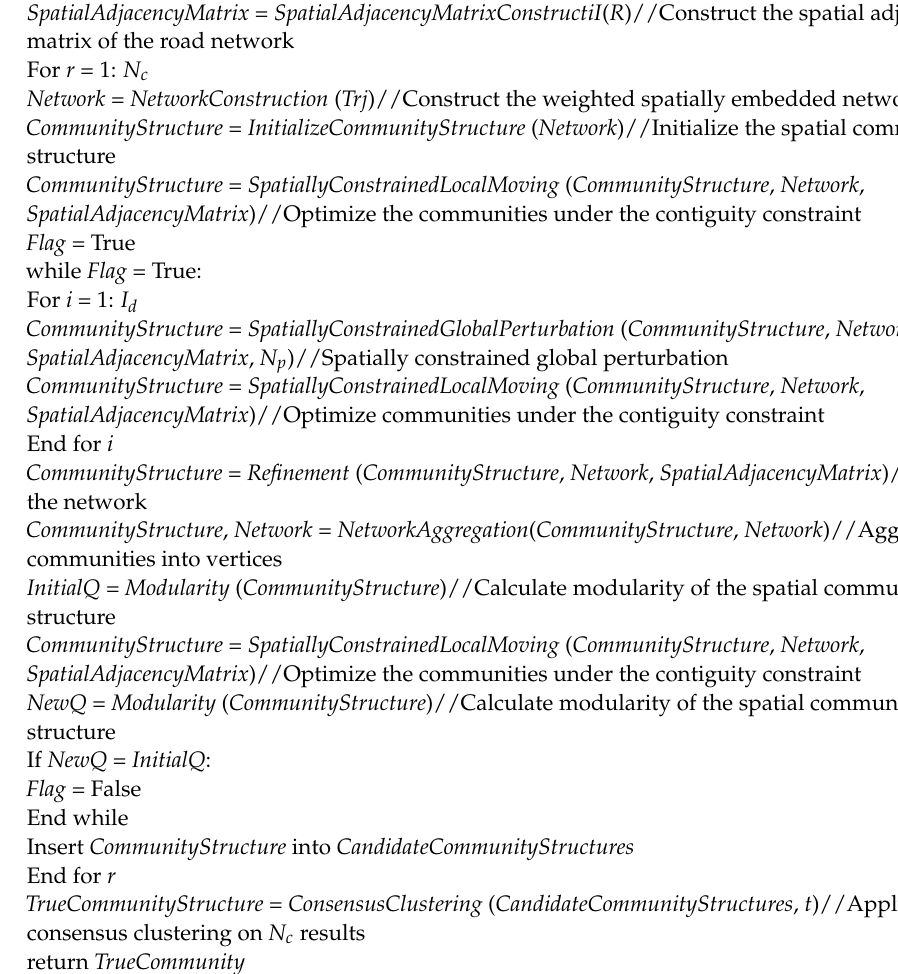
Algorithm 1 SCMiner (Input: R , Trj , I d , N p , N c , t